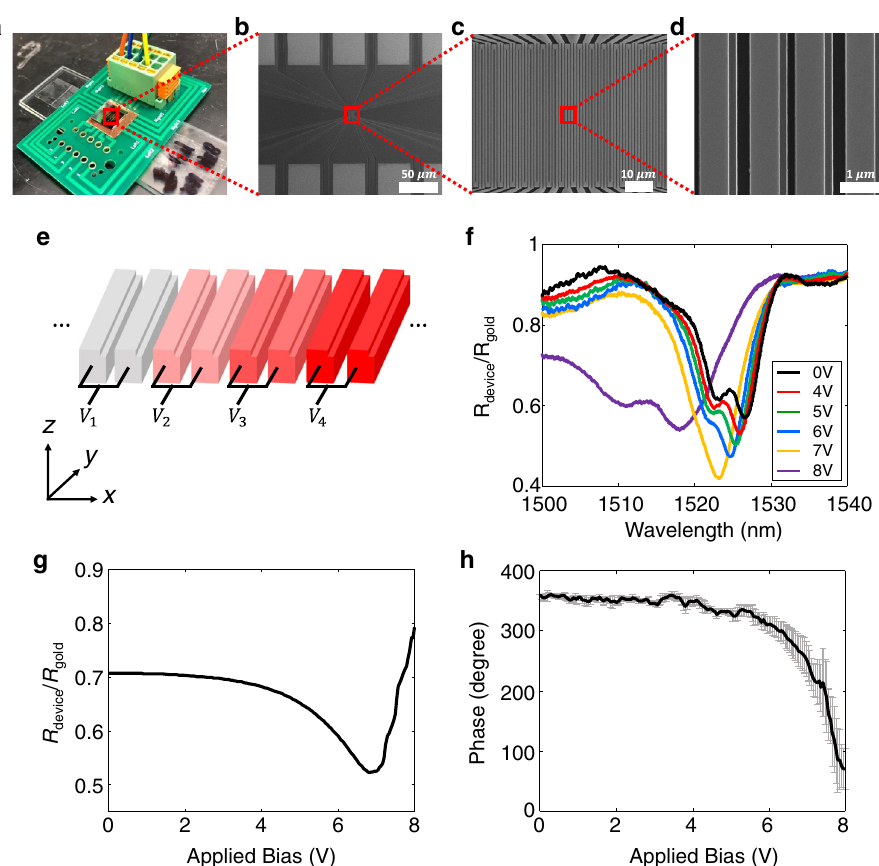
Fig. 3 | Optical characterization of nano-electromechanical metasurface tun- ing. a Optical image of the fabricated metasurface. Electrodes in the device are wire-bondedtoacustom-printedcircuitboard. b – d Scanningelectronmicroscopy images of the metasurface. Every pair of nanostructure is connected to the elec- trodes. Scale bars in b – d denote 500, 10, and 1 μ m, respectively. e Schematic of electrical con fi guration. Four different electrical biases, V 1 , V 2 , V 3 , and V 4 , are per- iodically applied to every four pairs of the nanostructures. f – h V 2 = V 4 and V 1 =